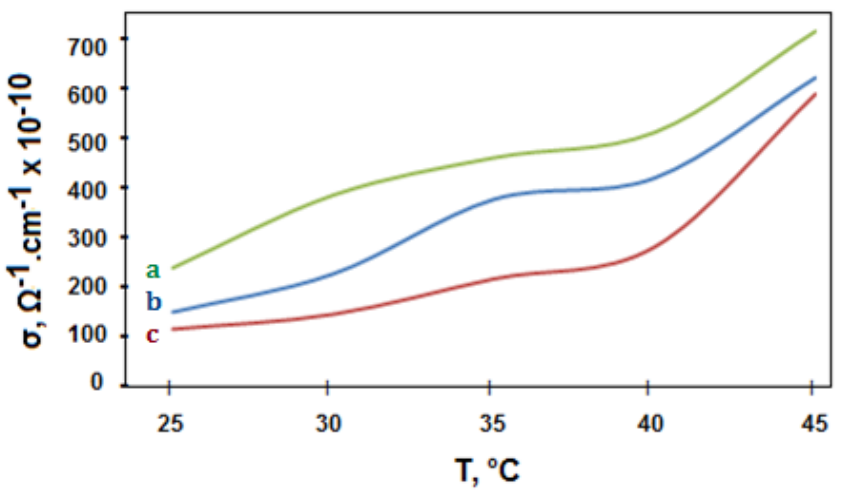
Figure 7. Conductivity diagram of (a) PES-ZnO, (b) PES, (c) PES-WO 3 systems. The microbial impacts of PES and its nanocomposites were evaluated against pathogenic Gram-negative bacteria, ( Pseudomonas aeruginosa ATCC 10145 and Escherichia coli ATCC 23282 ), Gram-positive bacteria ( Staphylococcus aureus ATCC 35556 and Bacillus subtilis ATCC 6633 ), and fungi ( Aspergillus niger ATCC 16404 and Candida albicans IMRU 3669 ) at a concentration of 5 mg/mL. The bacteria and yeast were grown on nutrient agar while the fungus was grown on Czapek’s Dox agar medium. Data in Table 2 indicate that the obtained composites’ antimicrobial effects range from moderate to slightly high on Gram-negative bacteria and from slightly high to high on Gram-positive bacteria and very high effect on fungi compared to the drug reference used. The values of the inhibition zones indicate the cytotoxic efficacy of these compounds against the studied fungi. The inhibition diameter values showed that the cytotoxic efficacies of these com- pounds are strongly related to their surface properties and the type of transition metal. The bactericidal effect of metal nanocomposite has been assigned to their small size and high surface to volume ratio, which allows them to interact closely with microbial membranes and is not solely owing to the release of metal ions in the medium. A cell wall exists around the outside of the microorganism cell membrane and it is essential to the survival of bacteria. Such a phenomenon can be explained based on Overtone’s concept and chelation theory